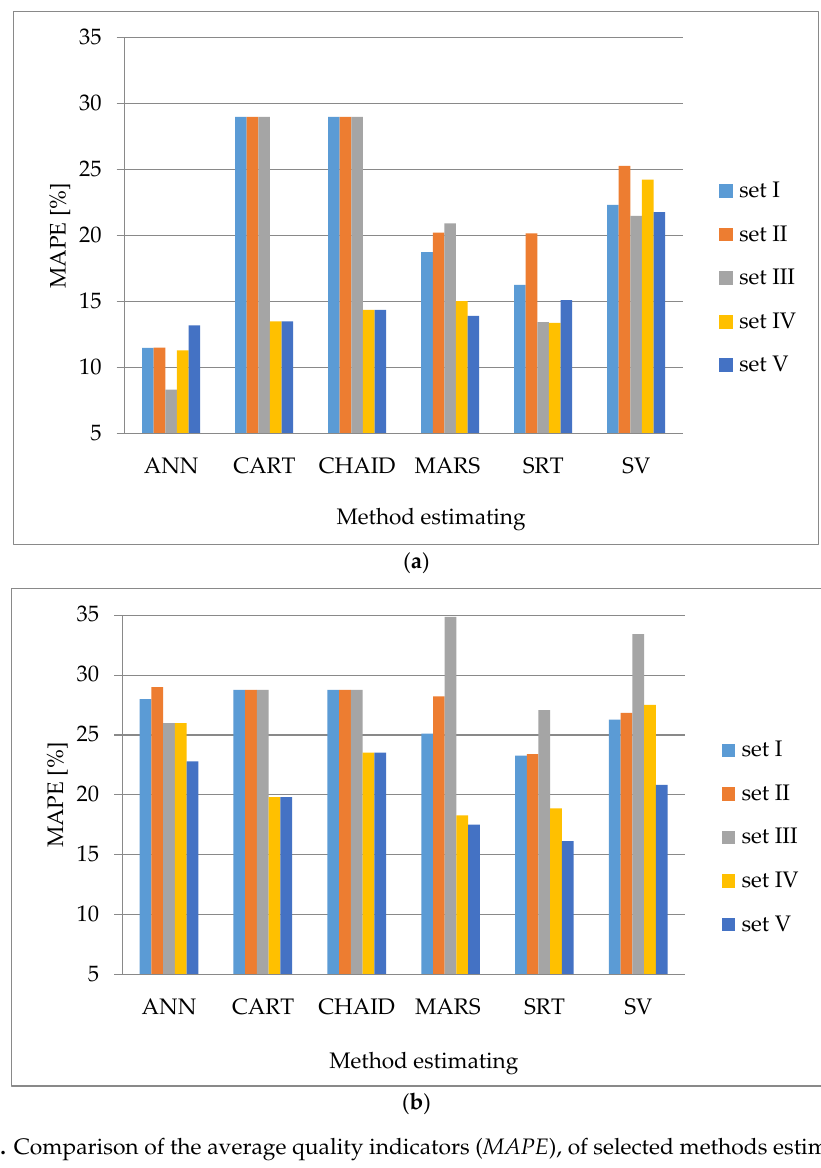
Figure 6. Comparison of the average quality indicators ( MAPE ), of selected methods estimating the reduction energy requirement taking into account all accessible input variables versus different set’s selection for: ( a ) learner, ( b ) test.